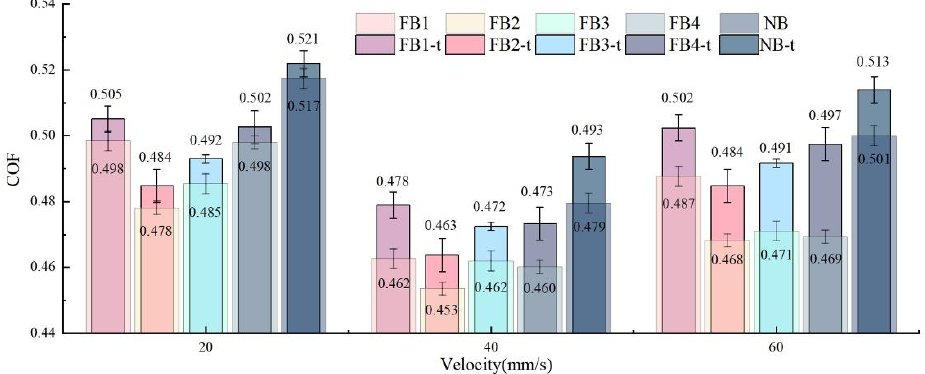
Figure 6. Comparison of theoretical COF (FB1 – FB4) and actual COF (FB1-t – FB4-t) of broaches with different surfaces.